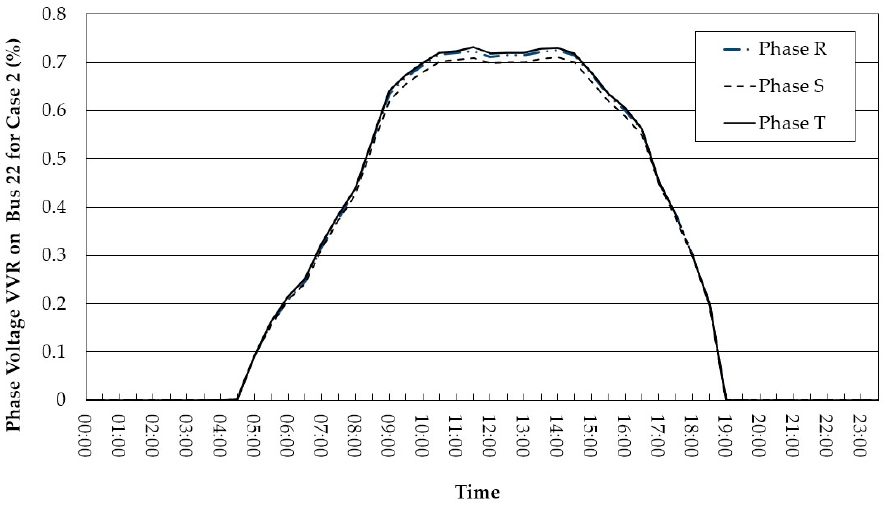
Figure 19. Three-phase VVR variation on Bus 22 for Case 2.